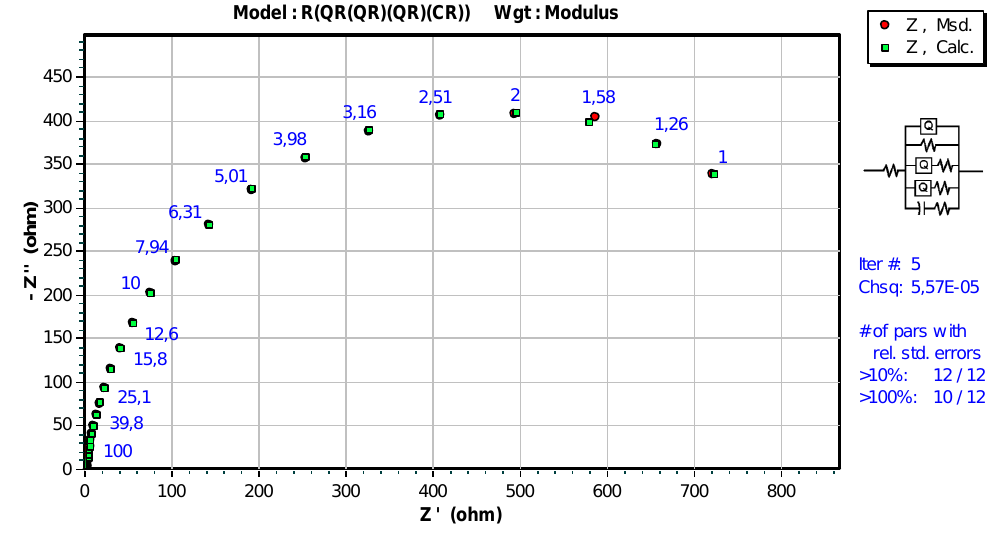
Figure 6. Nyquist plot of WC-6Co/4S.